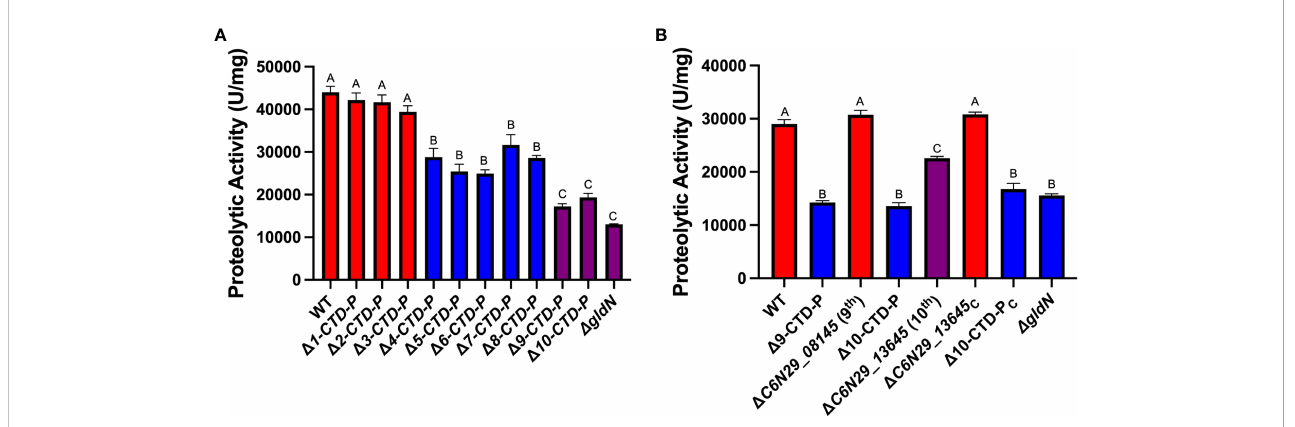
FIGURE 1 Effect of deletion of genes encoding peptidases with T9SS CTDs on extracellular proteolytic activities. (A) Strains examined were wild-type F. columnare (WT); FCB20 ( D 1-CTD-P); FCB98 ( D 2-CTD-P); FCB105 ( D 3-CTD-P); FCB109 ( D 4-CTD-P); FCB134 ( D 5-CTD-P); FCB139 ( D 6-CTD-P); FCB142 ( D 7-CTD-P); FCB145 ( D 8-CTD-P); FCB155 ( D 9-CTD-P); FCB167 ( D 10-CTD-P); D gldN . (B) Strains examined were wild-type F. columnare (WT); FCB155 ( D 9-CTD-P); FCB222 ( D C6N29_08145); FCB167 ( D 10-CTD-P); FCB230 ( D C6N29_13645); D C6N29_13645 mutant with wild-type C6N29_13645 restored to the chromosome ( D C6N29_13645 C ); D 10-CTD-P mutant with wild-type C6N29_13645 restored to the chromosome ( D 10-CTD-P C ); D gldN . Statistics correspond to one-way ANOVA with Tukey post-test comparing all conditions to wild type and each other. Same letter: nonsigni fi